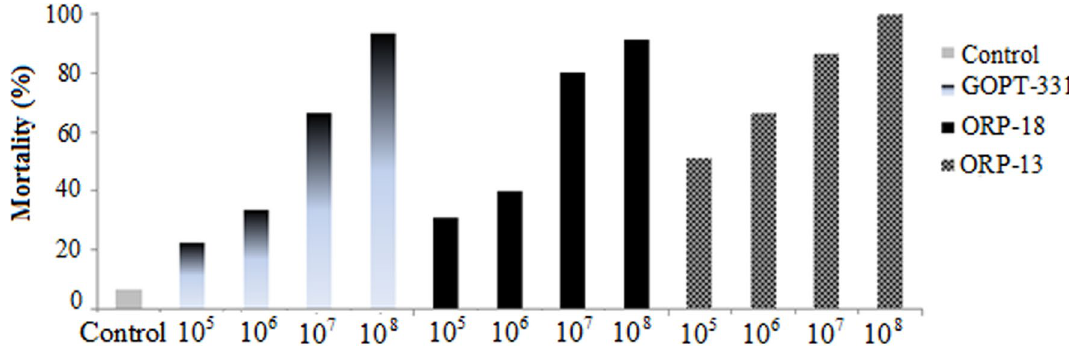
Fig. 1 Mortality rates of the second larval instar of Thaumetopoea wilkinsoni exposed to different fungal